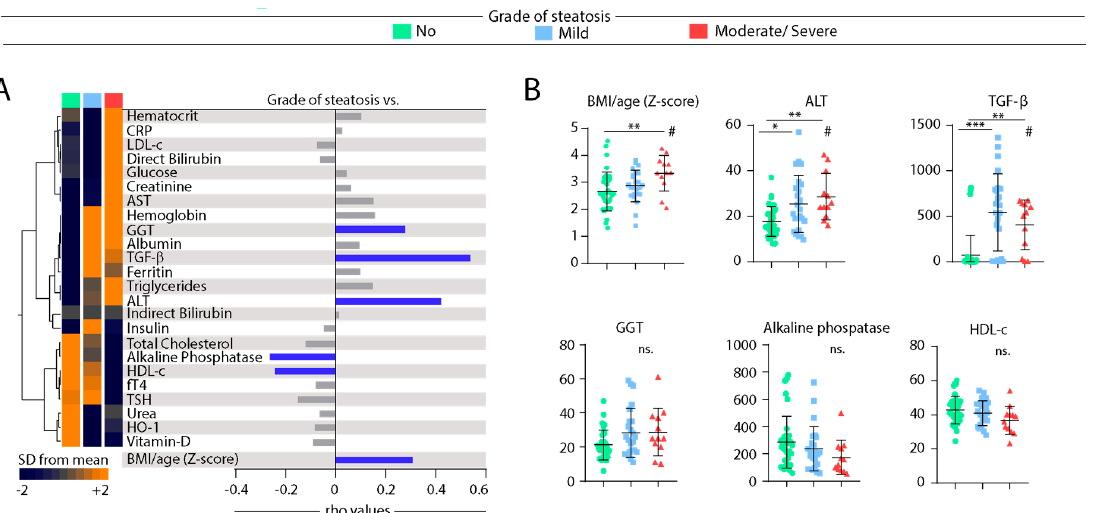
Figure 3. Spearman correlation of biochemical parameters in blood of patients according grade of hepatic steatosis. ( A ) Left panel: Data on each parameter was Log10 transformed. Mean values for each indicated clinical group were z-score normalized and a Hierarchical cluster analysis was performed to illustrate the overall biochemical profiles according the grade of diseases. Right panel: Correlation between grade of hepatic steatosis and biochemical parameters. Spearman correlation analysis was used, and rho values are shown. Blue lines represent correlations with statistical relevance. ( B ) Scatterplots of concentrations of indicated parameter which values presented statistically significant di ff erences between the study groups using the Kruskal-Wallis test with Dunn’s multiple comparisons ad hoc test (* p < 0.05, ** p < 0.01, *** p < 0.001, ns: nonsignificant) # represent statistical significance ( p < 0.05) of non-parametric linear trend ad hoc test. Bars represent median values whereas whiskers represent the interquartile ranges. Abbreviations (alphabetic order): ALT: alanine